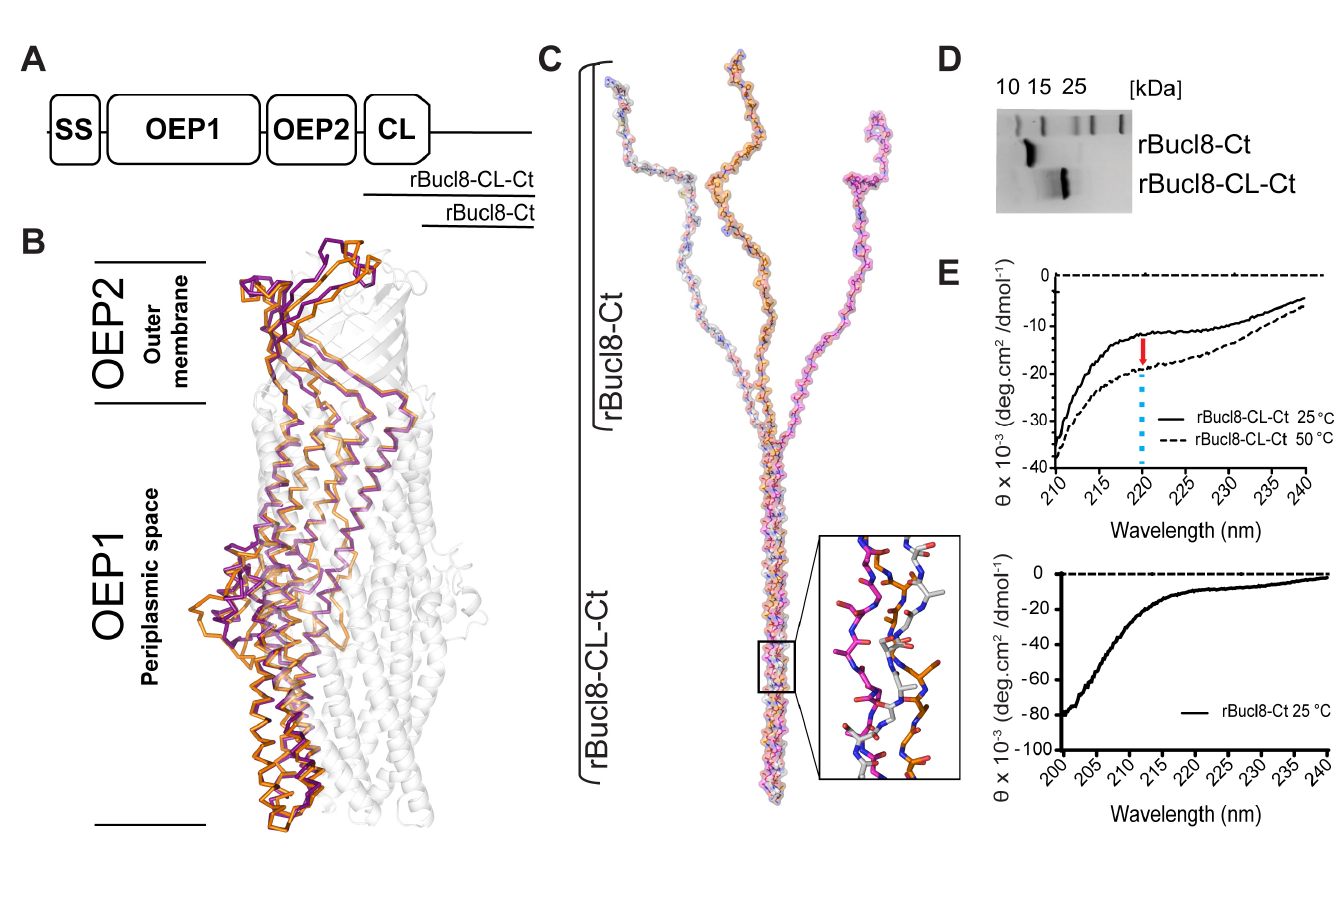
Fig 1. Structure analysis of the Bucl8 outer membrane protein. (A) Schematic organization of Bucl8 structural organization (not to scale). Bucl8 domains include: signal sequence (SS), outer membrane efflux protein domains 1 and 2 (OEP1, OEP2), collagen-like region (CL) and the C-terminus (Ct). The Bucl8 regions represented in recombinant proteins rBucl8-CL-Ct and rBucl8-Ct are depicted. (B) Homology modeling of Bucl8 intracellular OEP1-OEP2 region. Bucl8, modelled off the VceC structure (pdb code 1YC9), is shown in transparent grey. Alpha chains of Bucl8 periplasmic/outer-membrane domains (purple) superimposed onto OprM (1wp1) α - chains (orange) are shown in solid ribbon representations. (C) Structural modeling of Bucl8 extracellular CL-Ct region. Model depicts a homotrimeric polypeptide consisting of triple-helical CL domain of rBucl8-CL-Ct and unstructured C-terminus (rBucl8-Ct). The stick model in the inset depicts the triple helical fold of repeating (GAS) n collagen sequence of Bucl8-CL. (D) 4–20% SDS-PAGE analysis of recombinant Bucl8-derived constructs. rBucl8-CL-Ct and rBucl8-Ct polypeptides were expressed in E . coli and purified via His-tag affinity chromatography (original, uncropped gel image is shown in S1 Raw image). (E) Circular dichroism (CD) spectroscopy. (Upper plot) Wavelength scans of rBucl8-CL-Ct were performed at 25˚C (solid line) and 50˚C (dashed line). A drop in molar ellipticity maximum at 220 nm ( Θ 220 ) is observed in the CD spectra, indicating the transition from triple-helical (25˚C) to unfolded form (50˚C). (Bottom plot) CD spectrum of rBucl8-Ct at 25˚C indicates an unstructured form.